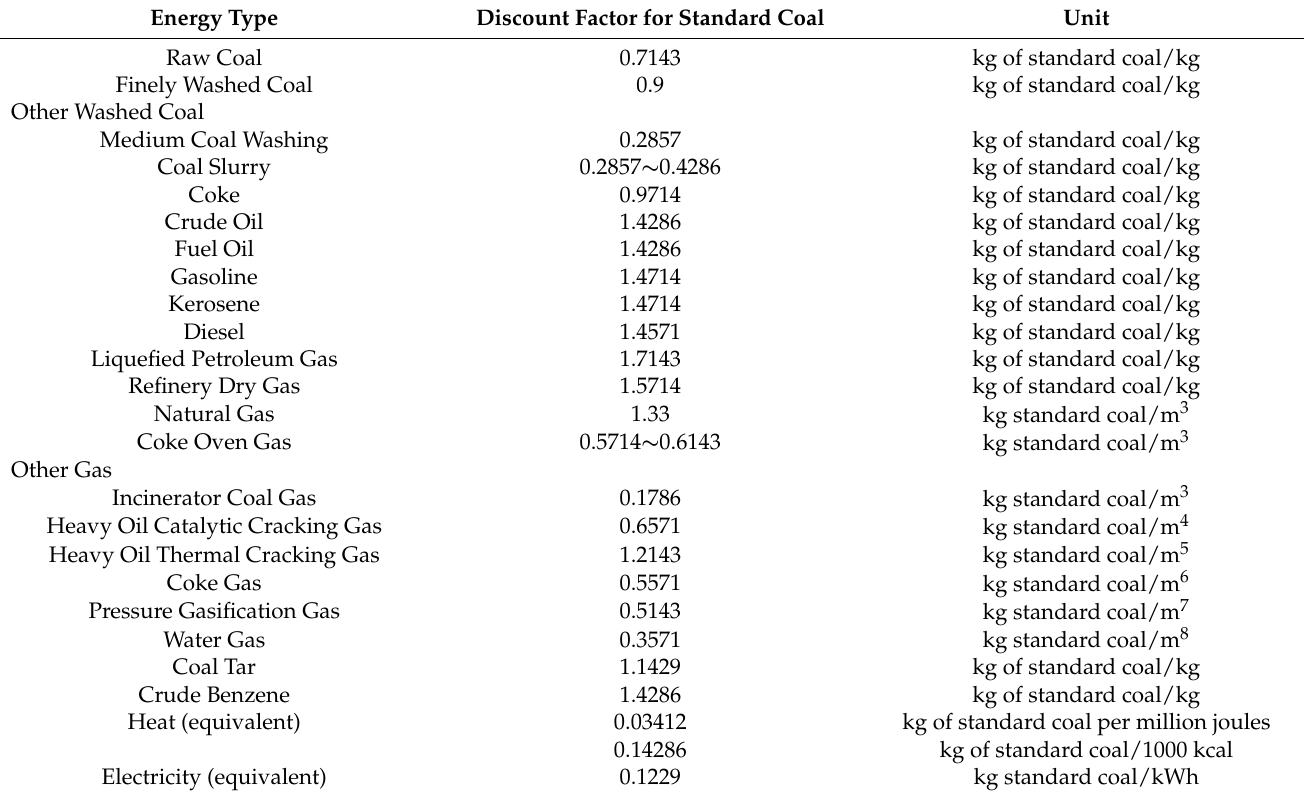
Table 4. Reference coefficients for various energy sources converted into standard